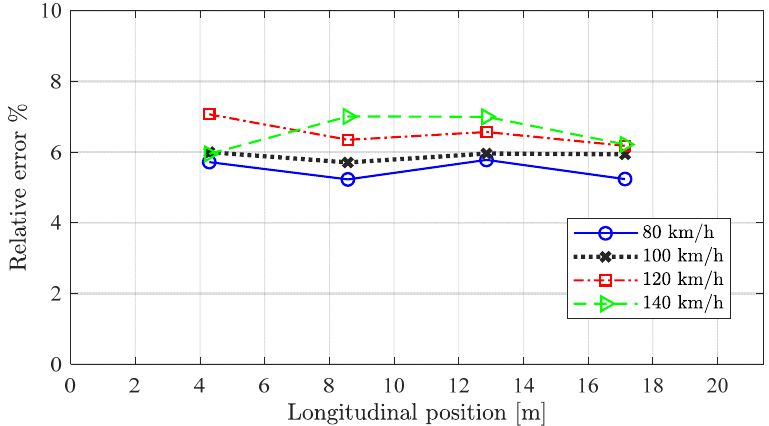
Figure 19. Relative identification error as a function of damage position and travelling speed With the CSA train, severe cross-girder damage and mild change of irregularity between the two runs.